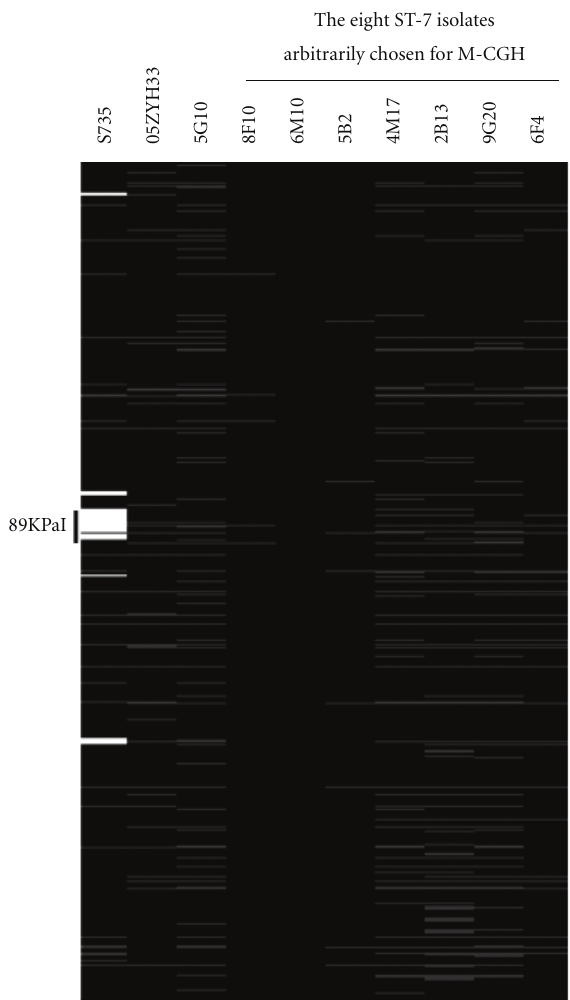
Figure 2: Schematic presentation of M-CGH data. Each column represented a strain, while each row standed for a di ff erent gene. The strain names were presented on the top. Genes were arranged according to the genomic location of the strain 05ZYH33. For each individual strain, the presence of a gene was represented by a black box, whereas the absence of a gene corresponded to a white box, and the grey area indicated the missing